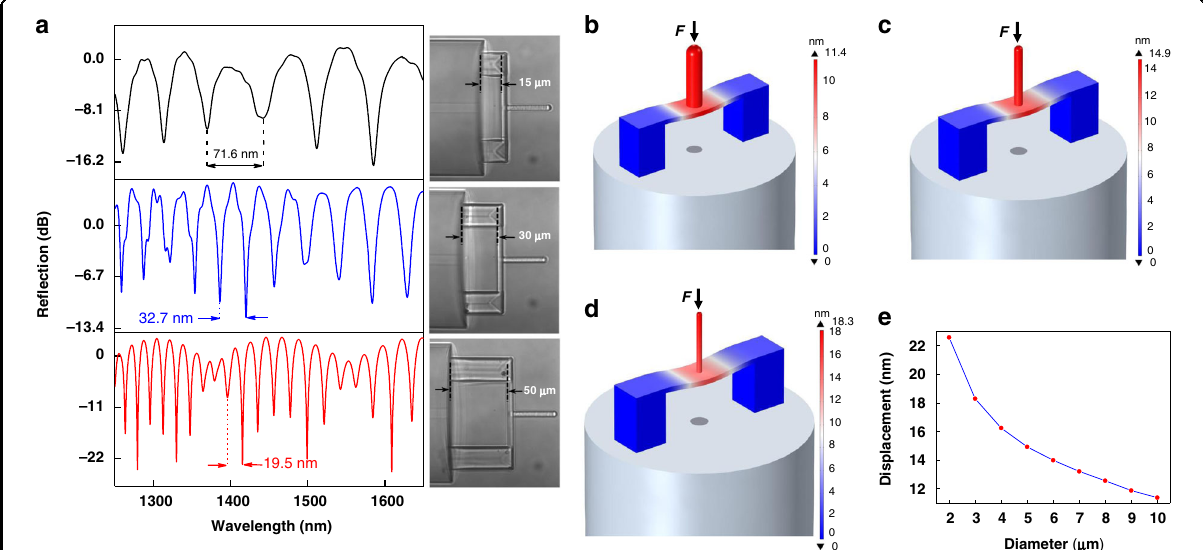
Fig. 2 Micro-force sensor structural characterization and static performance. a Optical microscopy images of the clamped-beam probe with different heights and their corresponding re fl ection spectra. b – d are the bending deformation simulation results of the sensor under the same micro force (1 μ N) acting on the probe with different diameters (10, 5, and 3 μ m). e Relationship between the probe diameter and fl exure deformation under the same micro force (1 μ